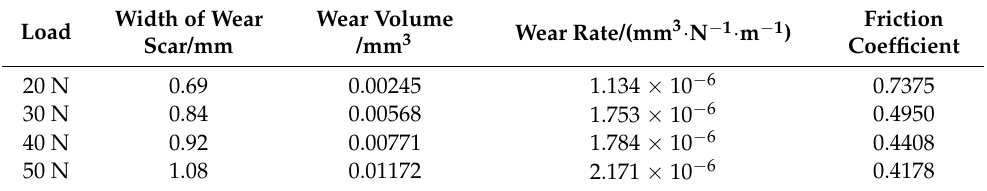
Table 3. Wear scar size and wear rate. Width of Load